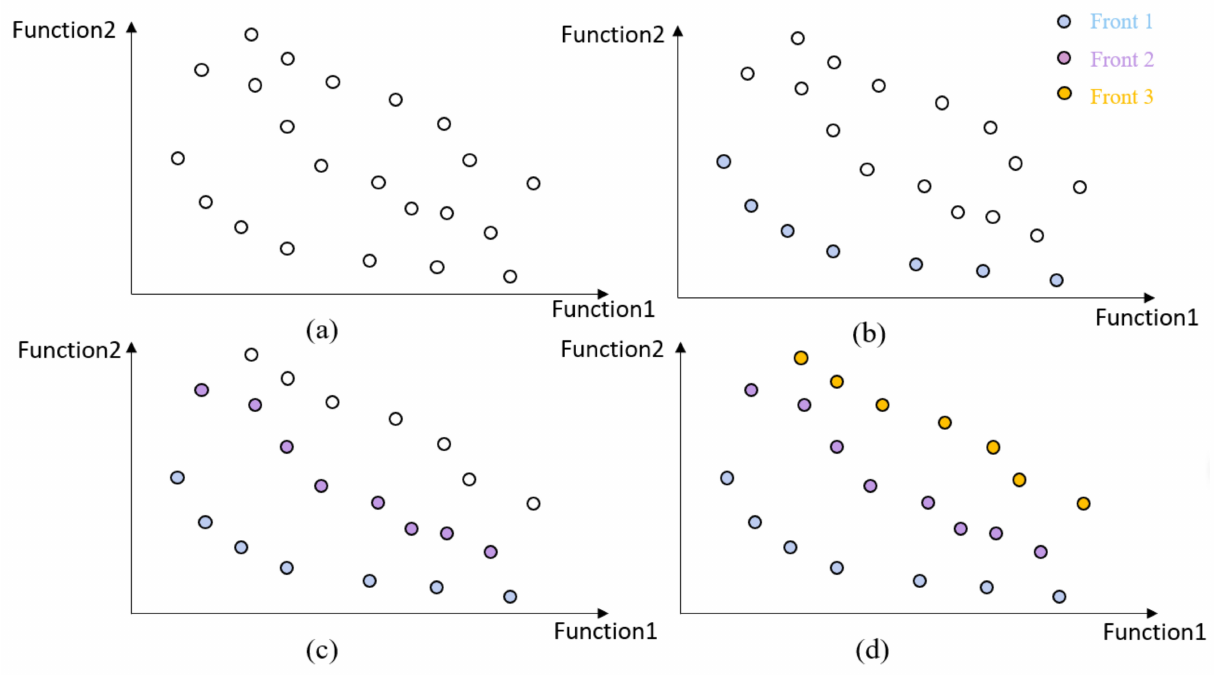
Figure 4. Pareto optimization